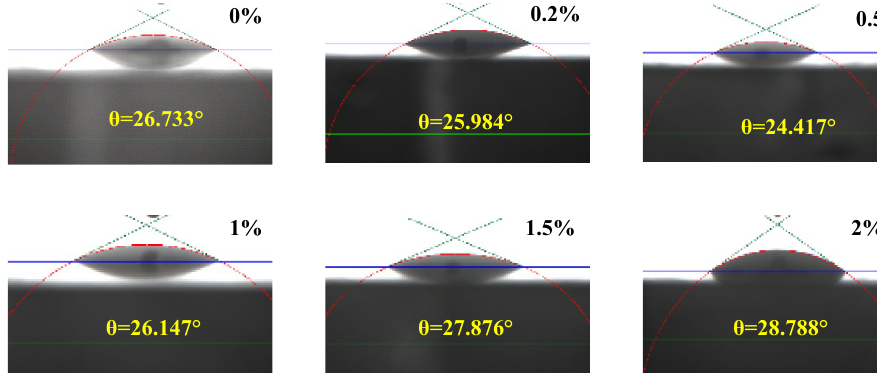
Figure 8 Contact angle under different nanoparticle concentrations